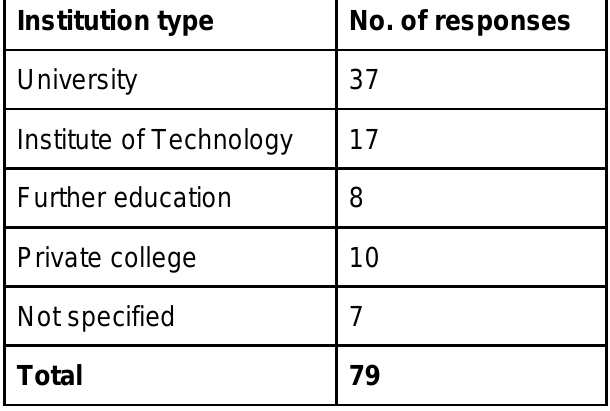
Table 2: Respondent profile by institution type Four themes were constructed through the analytic